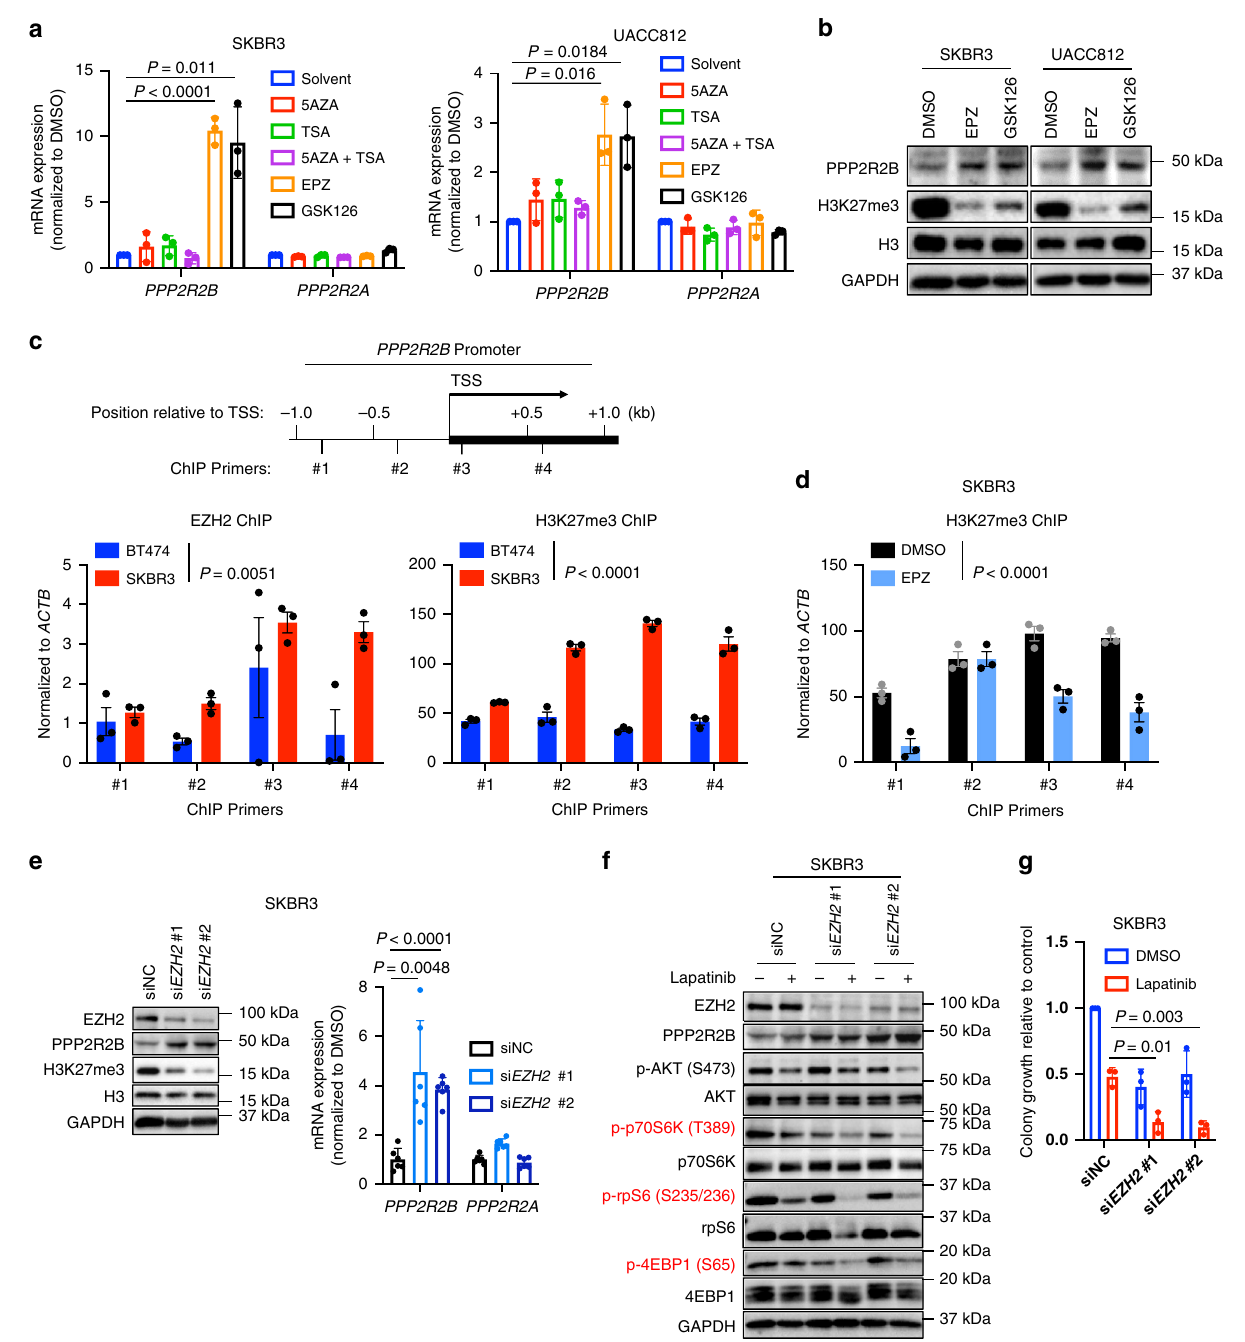
Fig. 4 PPP2R2B is repressed by EZH2 and EZH2 inhibitor treatment restores PPP2R2B expression. a RT-qPCR analysis of PPP2R2B and PPP2R2A in the indicated cell lines treated with the indicated epigenetic compounds. RT-qPCR data are expressed as mean ± s.d. of technical triplicates. b Western blot analysis ( n = 1) of the indicated proteins in cells treated with EPZ or GSK126. c Top panel: schematic showing the ChIP primer locations with respect to the transcriptional start site (TSS) of PPP2R2B promoter. Bottom panel: ChIP-qPCR of EZH2 (left) and H3K27me3 (right) enrichment at PPP2R2B promoter in BT474 and SKBR3, using the four pairs of primers shown at the top. d ChIP-qPCR of H3K27me3 enrichment on PPP2R2B promoter in SKBR3 treated with DMSO or 1 μ M EPZ for seven days, with the primers shown in c . Data in c and d are expressed as mean ± s.e.m. of technical triplicates. P values in c and d were determined by two-way ANOVA. e Western blot analysis (left) and RT-qPCR (right) in SKBR3 transfected with siNC or siRNAs against EZH2 . qPCR data are expressed as mean ± s.e.m. of two independent experiments performed in triplicate ( n = 6). f Western blot analysis with cells from e treated with 40 nM lapatinib. Effectors downstream of mTOR were highlighted in red. g Soft agar assay with cells from e treated with 20 nM lapatinib. Data are expressed as mean ± s.d. of three independent knockdown experiments. P values in a , e , and g were determined with two-tailed Student ’ s t -test, and corrected with Bonferroni